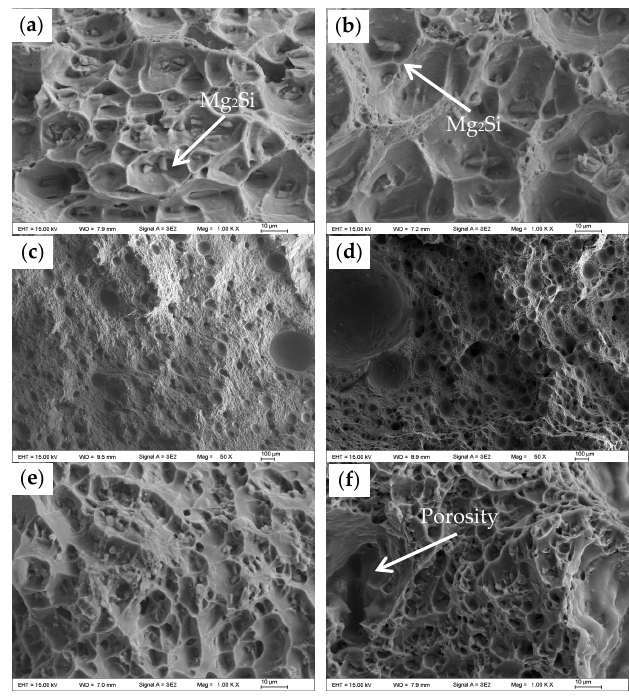
Figure 12. SEM fracture morphologies of AG-joints: ( a ) sample No. 2; ( b ) sample No. 7. SEM fracture morphologies of SAG-joints: ( c ) sample No. 2 at low magnification; ( d ) sample No. 7 at low magnification; ( e ) sample No. 2 at high magnification; and, ( f ) sample No. 7 at high magnification.